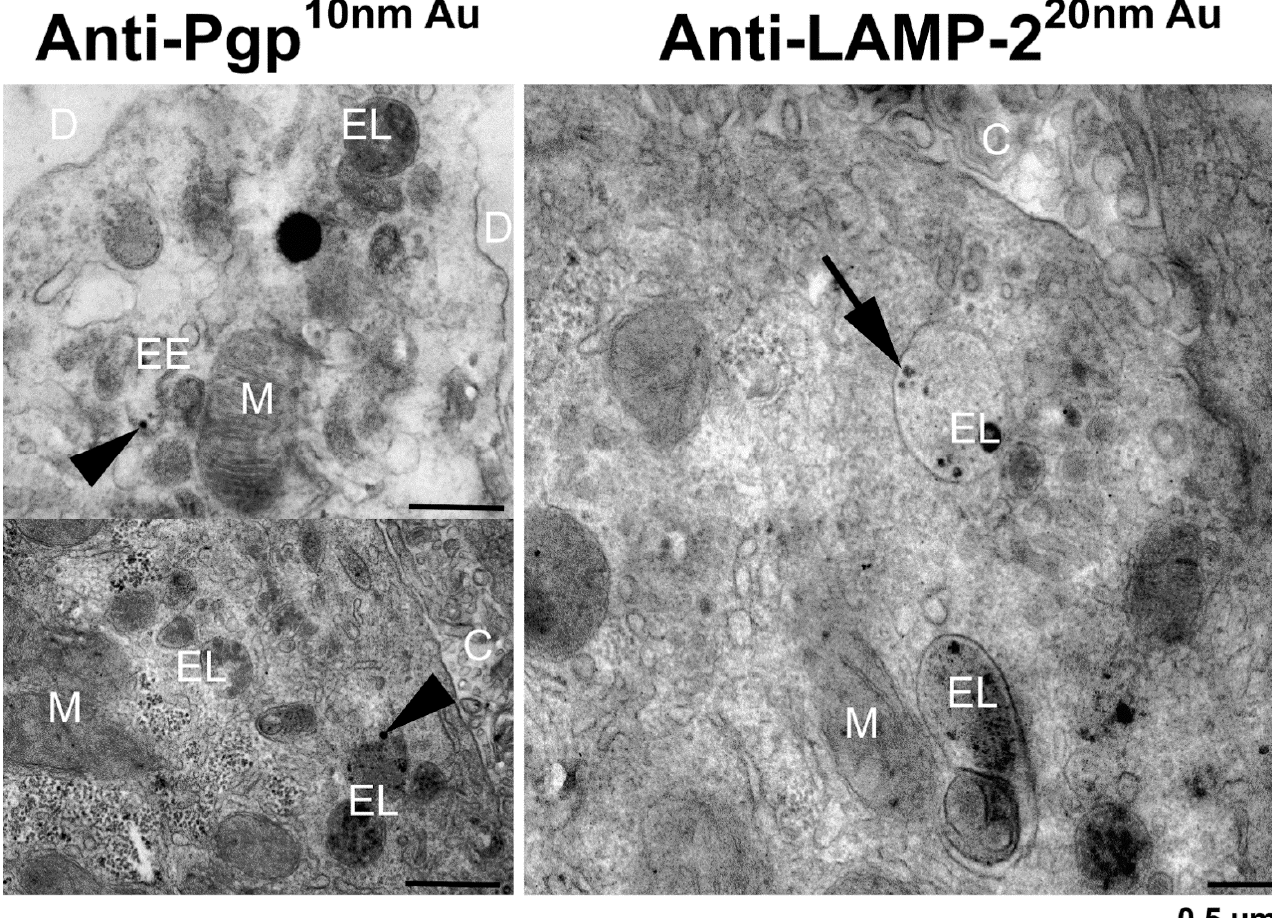
Figure 8. Ultrastructure of the in situ localization of Pgp and LAMP-2 in rat hepatocytes by pre- embedding immunogold labeling. In the hepatocytes, Pgp could be immunolocalized in the early endosomes (arrowhead in EE) near the basolateral plasma membrane as well in one of ten sectioned endolysosomes (arrowhead in EL) near the canalicular plasma membrane (C). Mitochondria (M) are not marked. Space of Disse (D). In comparison, LAMP-2 was only present in the endolysosomes (arrow in EL). Note that—due to the continuous generation of (i) late endosomes by new endocy- tosed material and (ii) of endolysosomes (or secondary lysosomes) by fusion with primary lyso- somes—a differentiation of late endosomes and endolysosomes is not possible by the methods used here, so all these structures were termed endolysosomes (EL). Note that most endolysosomes con- tain membrane-bound intraluminal vesicles (ILVs); thus, these organelles are also termed mul- tivesicular bodies (MVBs).